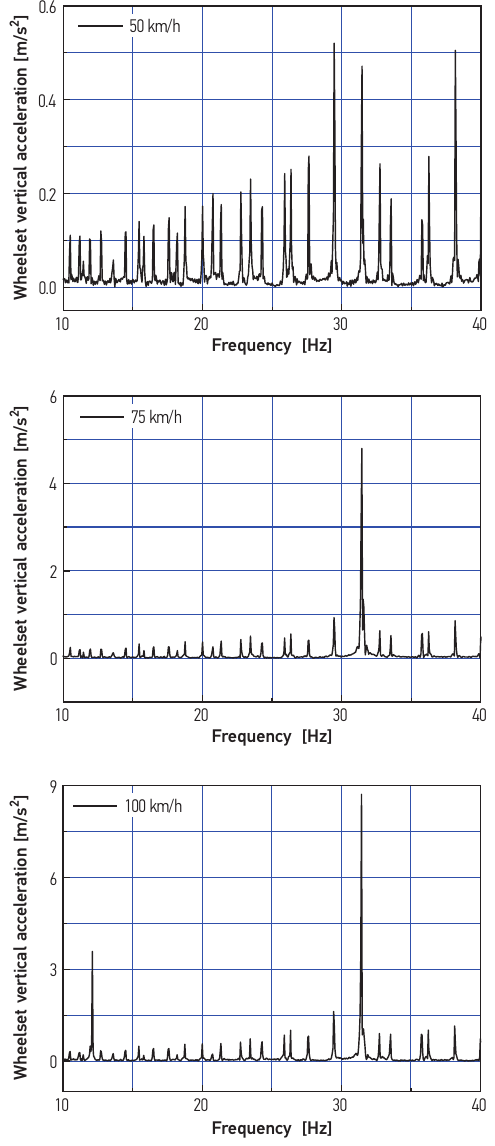
Fig. 7. The wheelset vertical vibration acceleration frequency